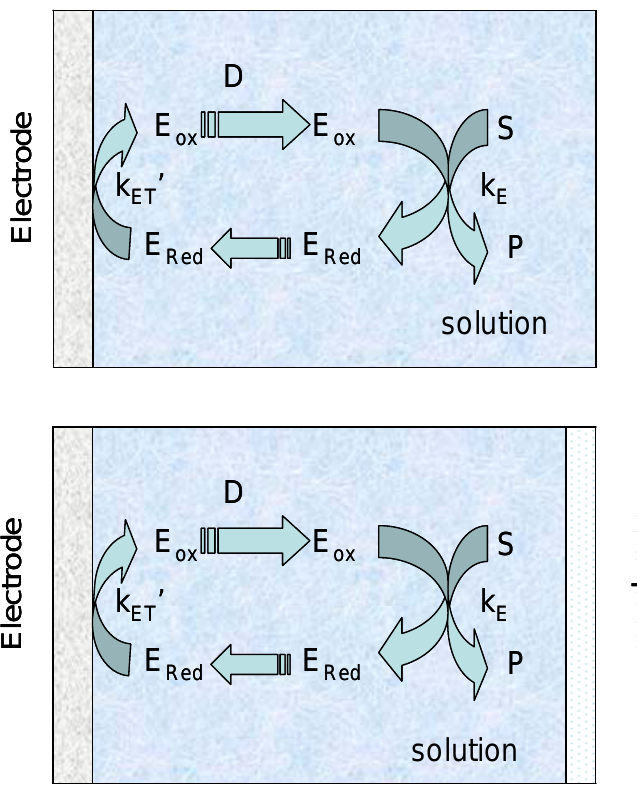
Figure 3. Schematic representation of electro-enzyme transport and kinetics. (a) Free semi infinite enzyme diffusion and reaction . (b) Membrane bounded enzyme reaction and